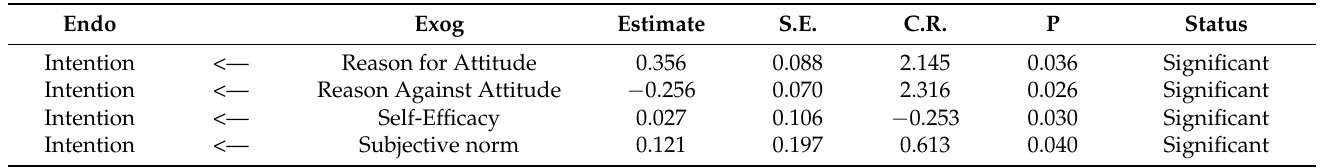
Table 5. Standardized results during